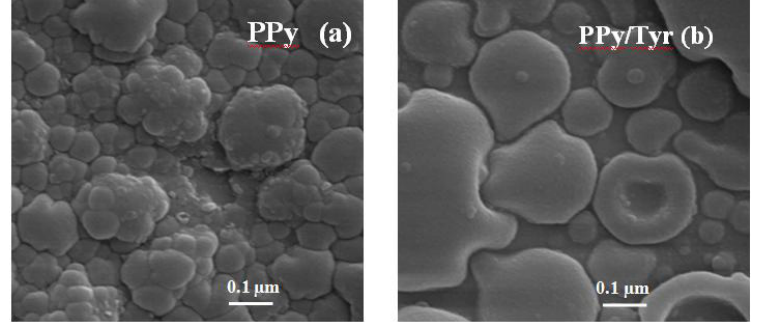
Figure 2. Scanning electron microscope (SEM) images for the ( a ) PPy and ( b ) PPy/Try films obtained after 10 voltammetric